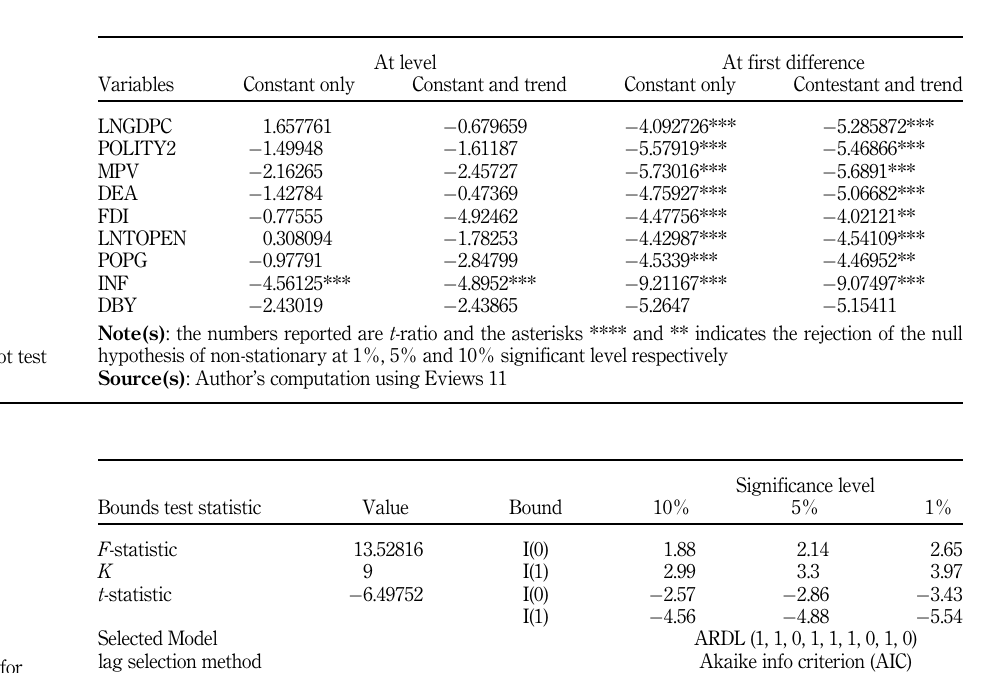
Table 4. Bounds test for co-integration